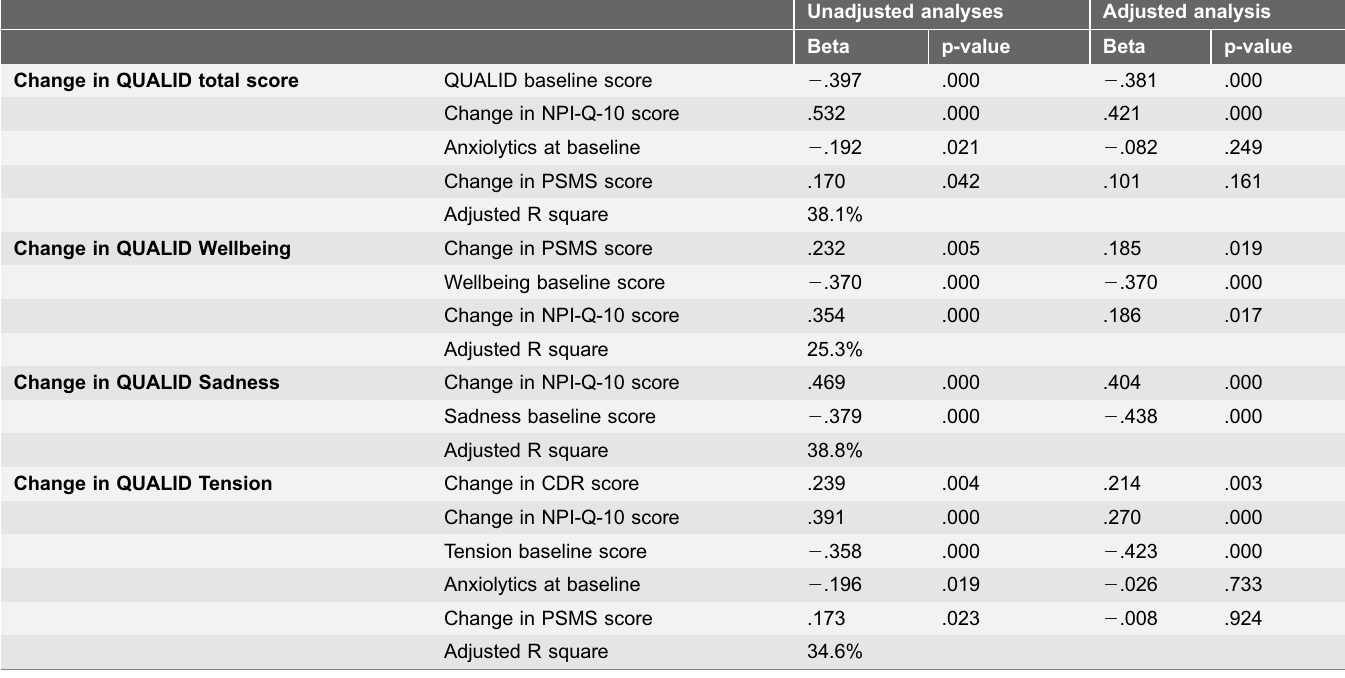
Table 5. Variables associated with a change in QUALID scores (total and subscale